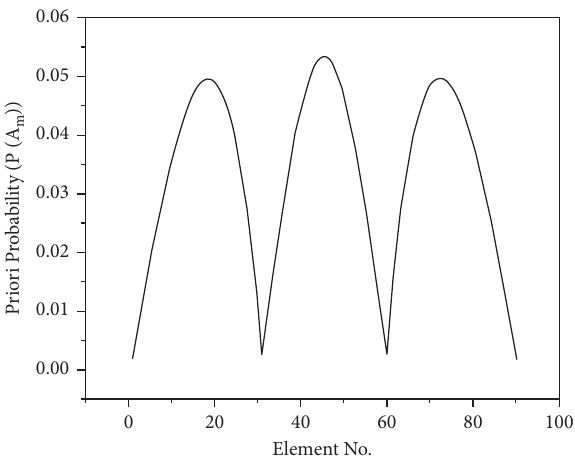
Figure 24: Damage prior probability of continuous girder.